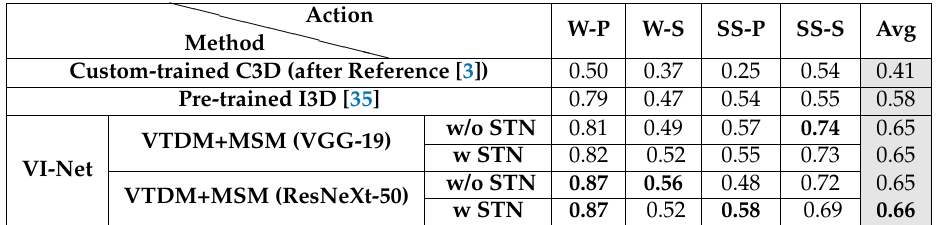
Table 4. Comparative cross-subject results on QMAR. The bold numbers show the best result for each action